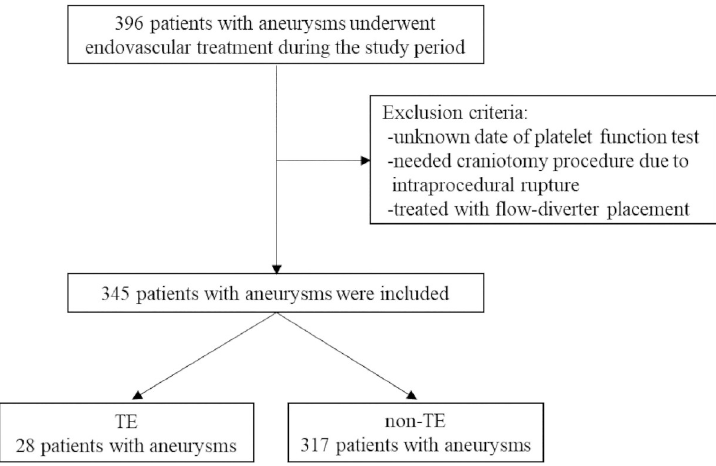
Fig 1. Flowchart showing patient participation. Abbreviations: TE, thromboembolic